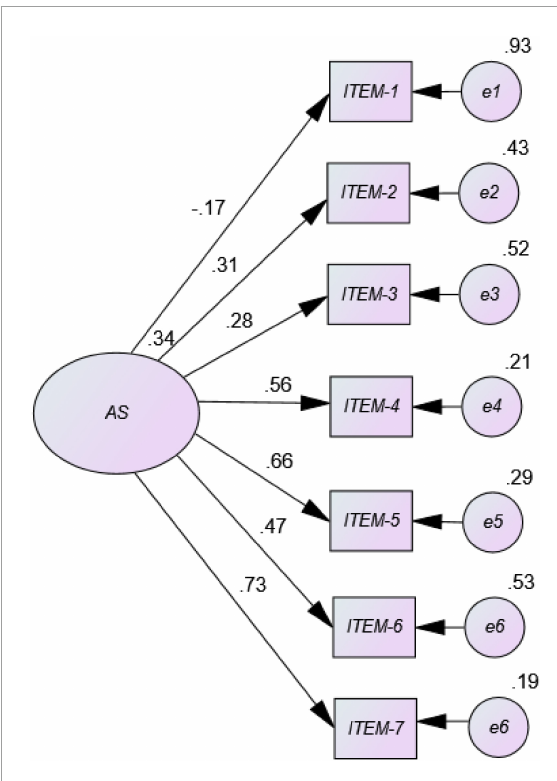
FIGURE1 Path diagram of the unidimensional model corresponding to AS in Spanish university students (Model 1 = Original version).